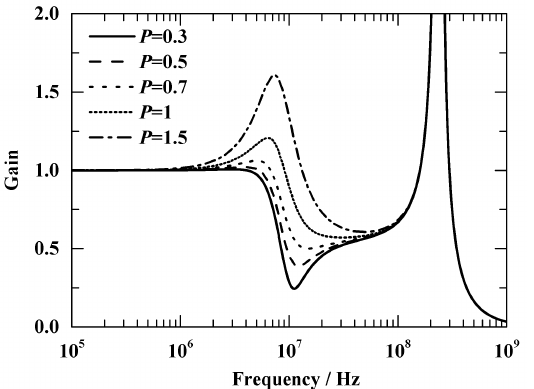
Figure 10. Amplitude – frequency characteristics with different degrees of compensation.